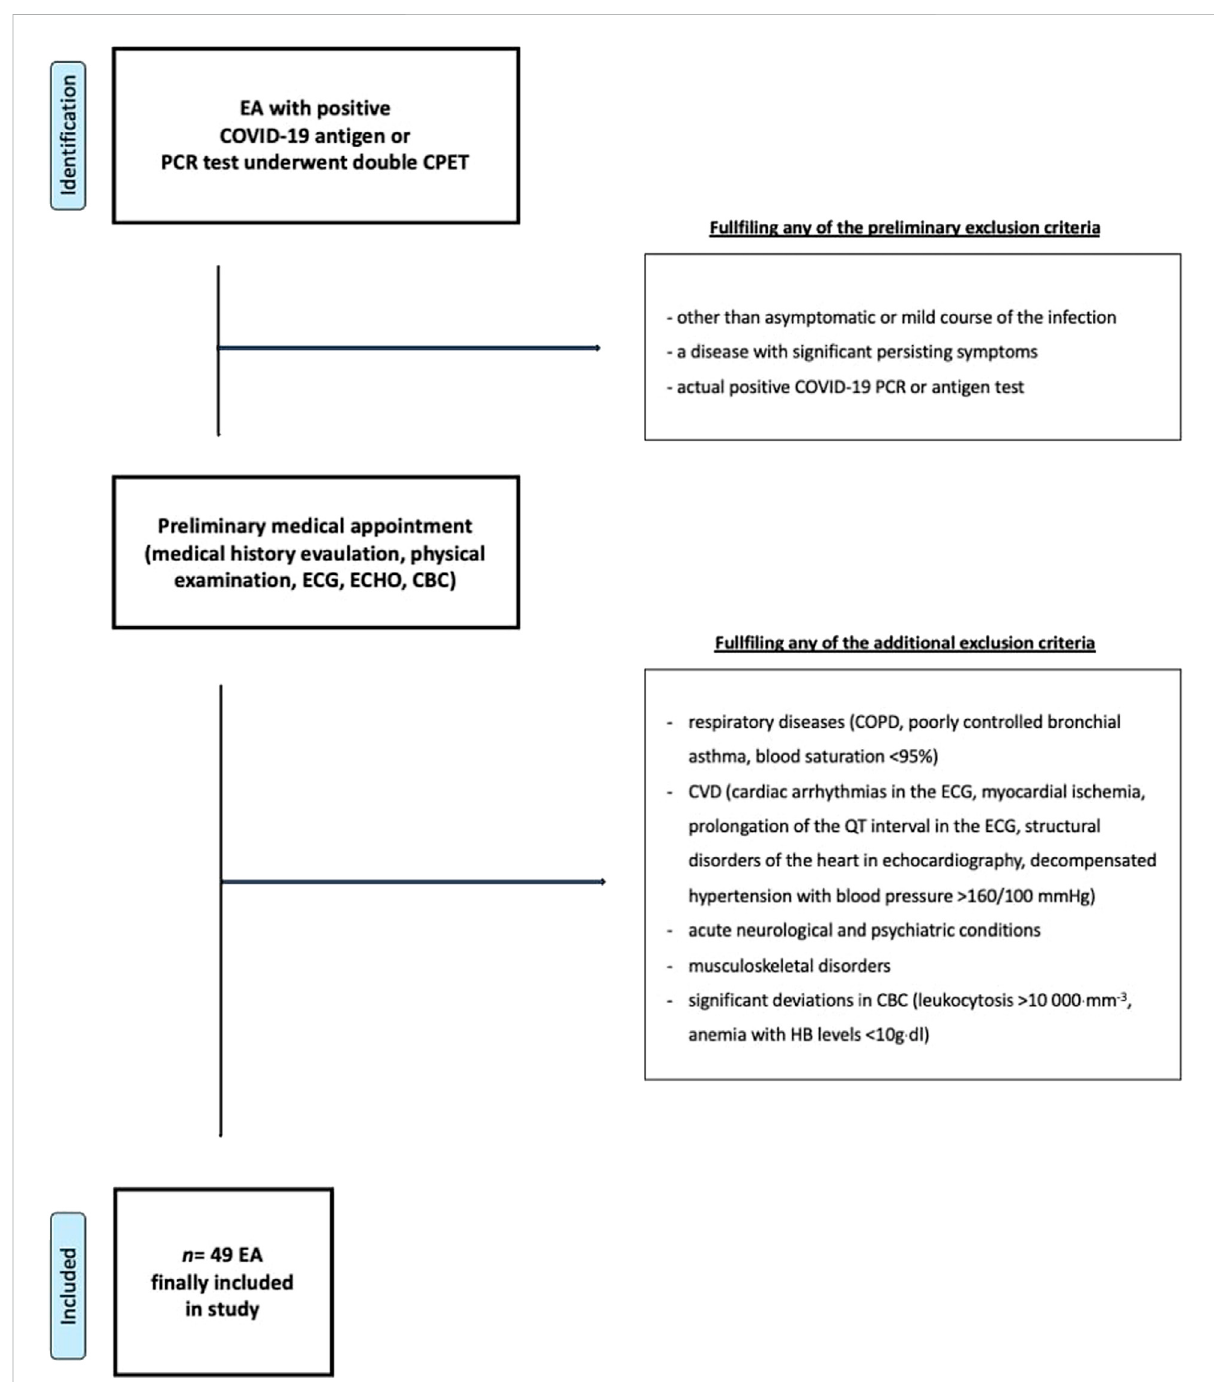
FIGURE 1 Participants selection protocol. Abbreviations: EA, endurance athlete; CPET, cardiopulmonary exercise test; ECG, 12-lead electrocardiogram; CBC, complete blood count; COPD, Chronic obstructive pulmonary disease; HB, blood